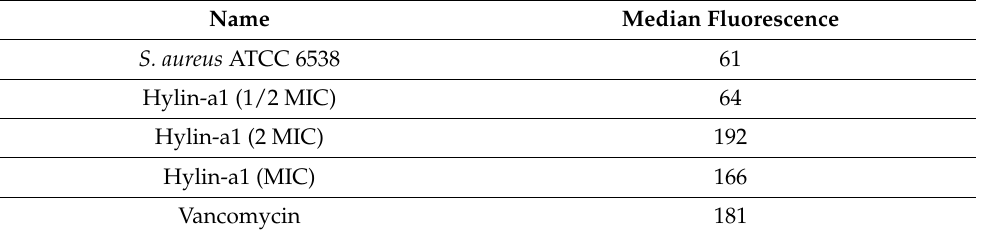
Figure 7 . Flow cytometric analysis. The DNA-intercalating dye propidium iodide (PI) was used to evaluate the cell membrane integrity via flow cytometry. The fluorescence intensity was monitored after treating with Hylin-a1. Flow cytometry was performed using a FACScan instrument. ( a ) Untreated bacteria, control; ( b ) bacteria treated with vancomycin (6.9 µ M); ( c ) bacteria treated with Hylin-a1 at 2MIC concentration; ( d ) bacteria treated with Hylin-a1 at MIC concentration; ( e ) bacteria treated with Hylin-a1 at 1 / 2 MIC concentration. Table 2. Flow cytometry analysis . Median fluorescence values for each compound tested.